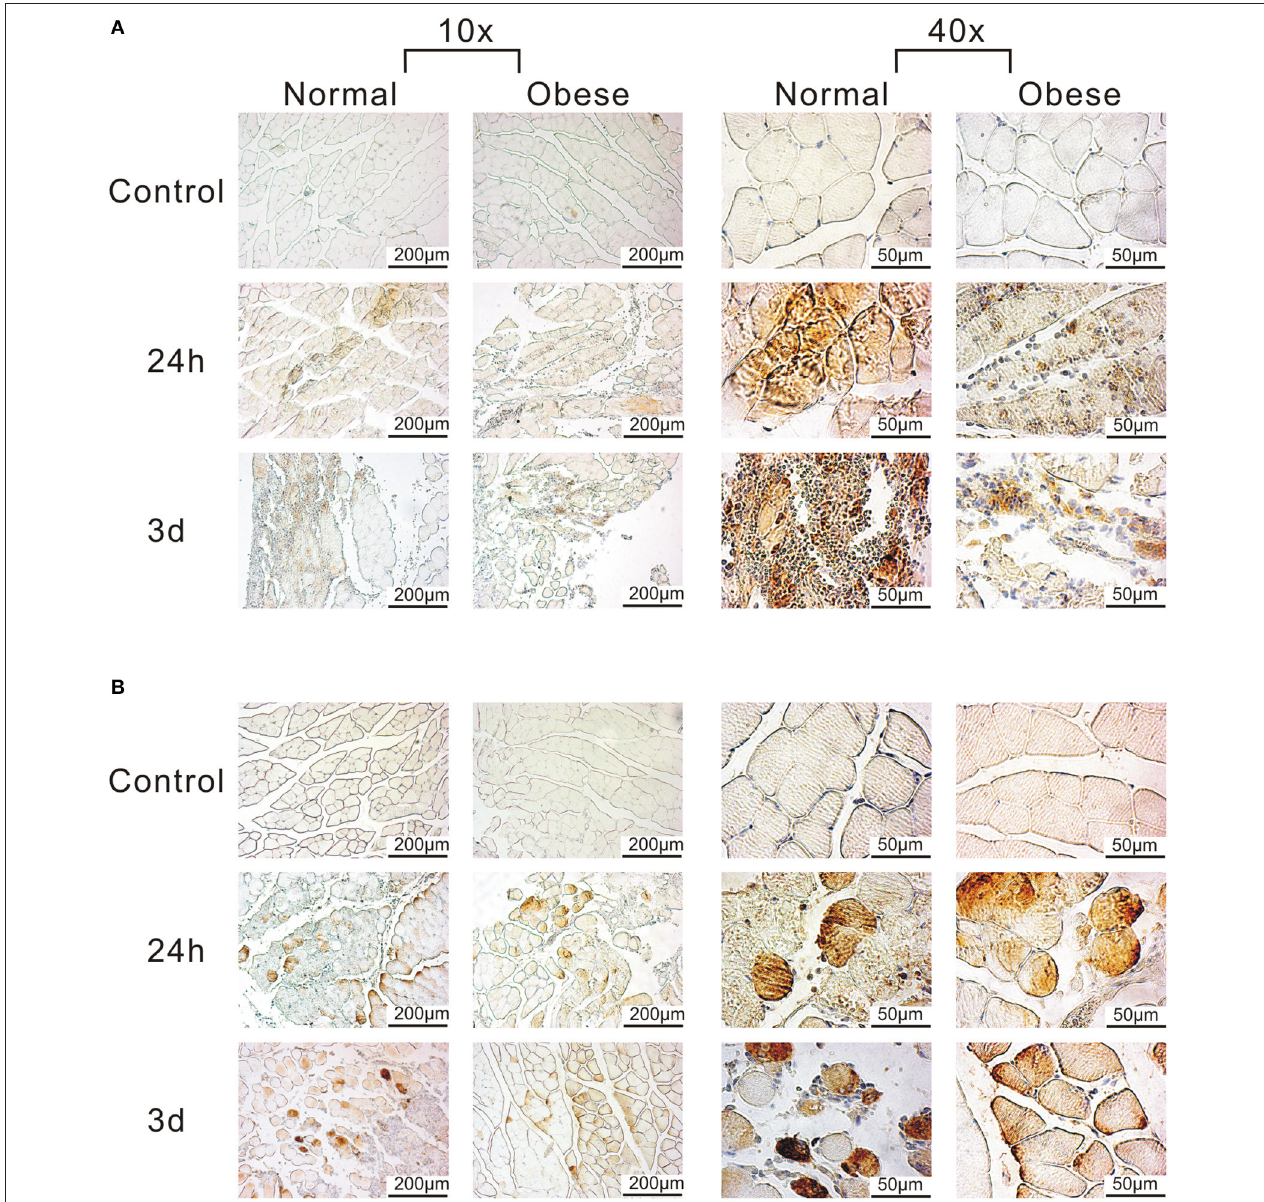
FIGURE 7 | Detection of C3ar and C5ar in muscle tissue of normal weight and obese mice by IHC. (A) Anti-C3ar-labeled muscle shows stronger signals for normal weight when compared to obese. (B) Anti-C5ar-labeled muscle shows a partially increased signal, and slightly increases over time, also indicating the negative role of obesity. Pictures were taken with Olympus IX81 using Xcellence v.1.2. Scale = 200 µ m at 10x magnification; Scale = 50 µ m at 40x